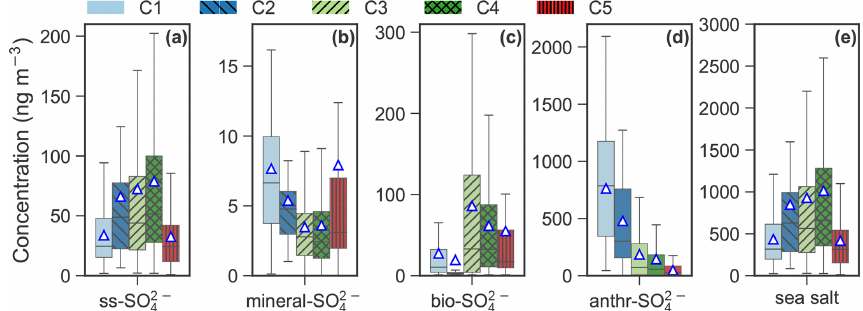
Figure 7. Box plot of (a) sea salt SO 2 − (ss-SO 2 − ), (b) mineral SO 2 − (mineral-SO 2 − ), (c) biogenic SO 2 − (bio-SO 2 − ), (d) anthropogenic 4 4 4 4 4 4 SO 2 − (anthr-SO 2 − ) and (e) sea salt for each cluster. The (e) sea salt aerosol is calculated by multiplying the ss-Na + by a factor of 3.248 4 4 (Kerminen et al., 2000; Brewer, 1975). The mean values are marked as